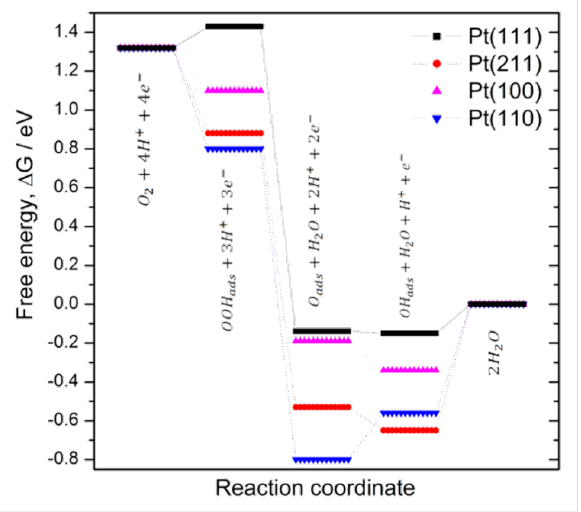
Figure 4: Potential free energy diagram for oxygen reduction over Pt(111), Pt(211), Pt(100) and Pt(110) at 0.9 V, on the basis of reported adsorption energies